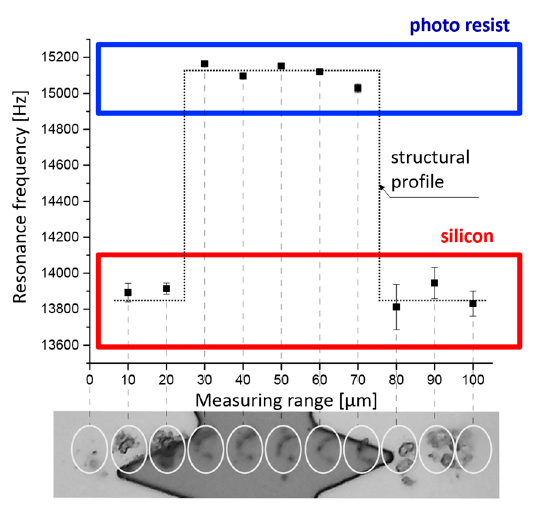
Figure 4. CRS measurement of a PR-pattern on a silicon wafer over a range of 100 µm.